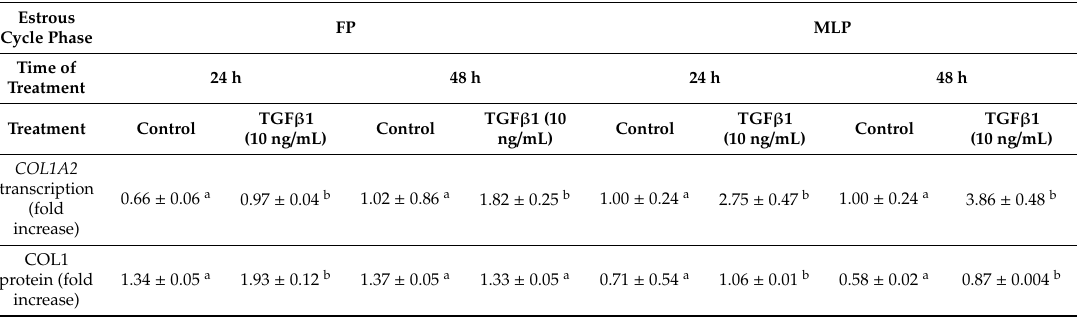
Table 2. The e ff ect of transforming growth factor beta β 1 (TGF β 1) (10 ng / mL) on COL1A2 mRNA transcription and COL1 protein relative abundance in follicular phase (FP) and mid-luteal phase